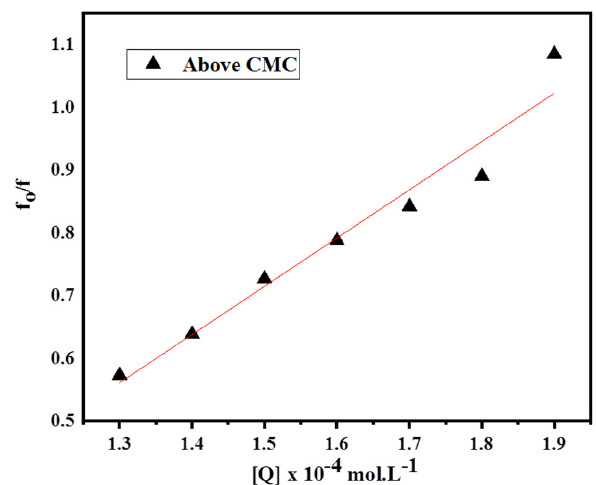
Figure 6. Stern ─ Volmer plot of interaction of SDS in the CAD ‐ ethanol system at 298.15 K below CMC.